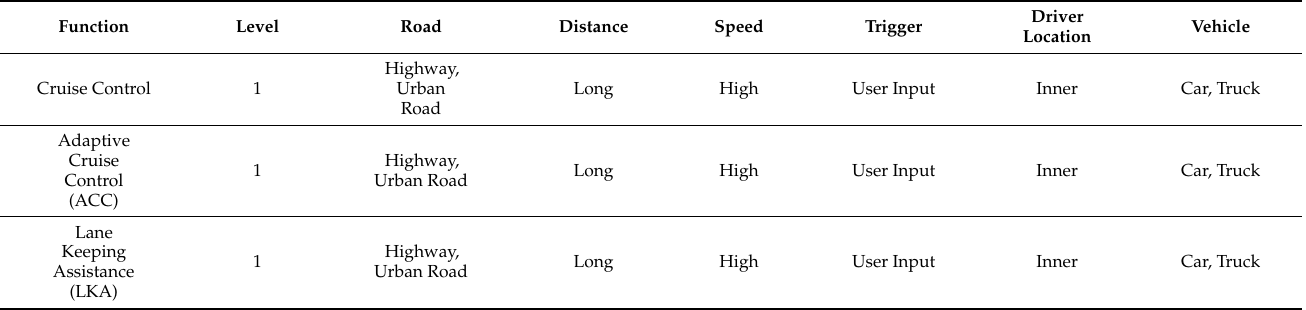
Table 7. Scenario